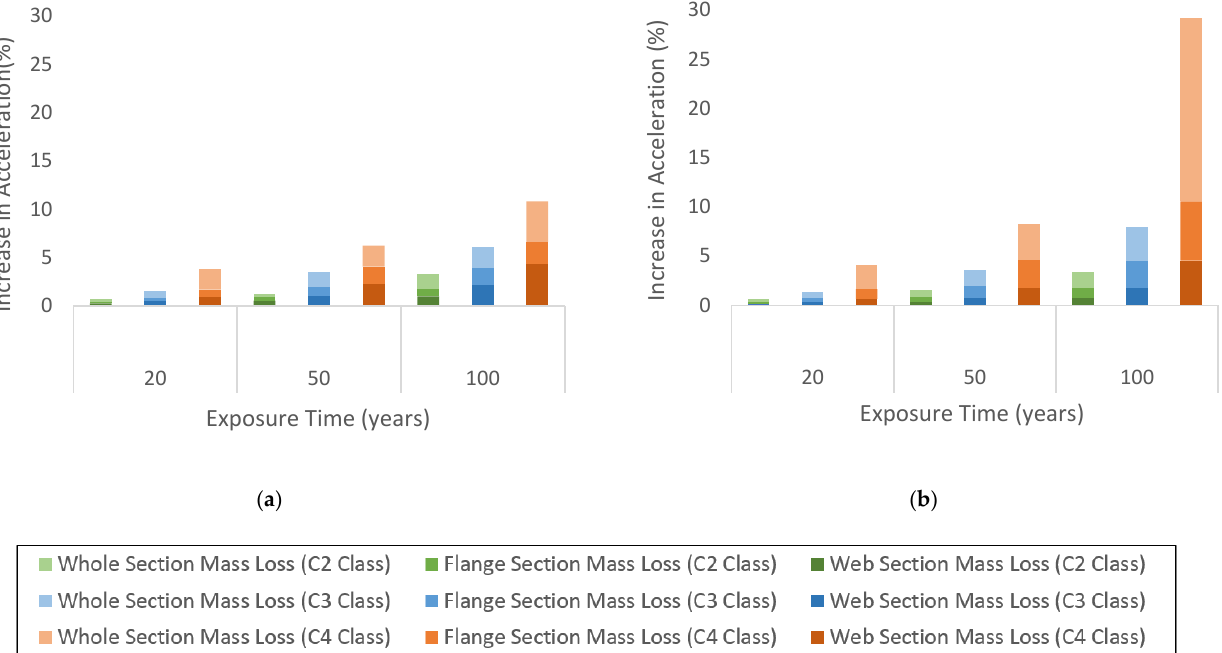
Figure 12. Increase in acceleration with respect to time for: ( a ) node D; ( b ) node E. It should be noticed that the change in the mechanical properties results in negligible impact on the drifts and accelerations (below